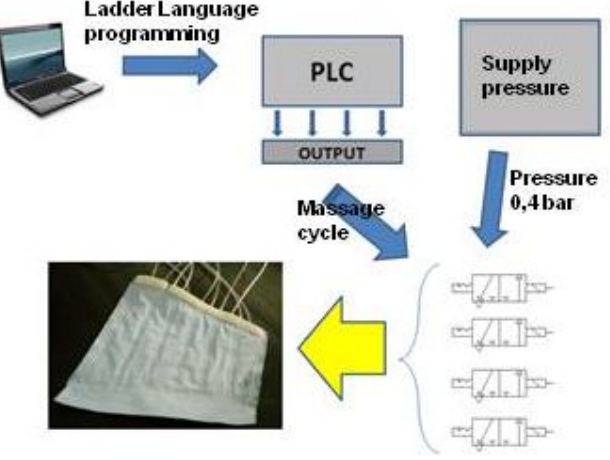
Figure 17. Operating schematics for an inflatable compression